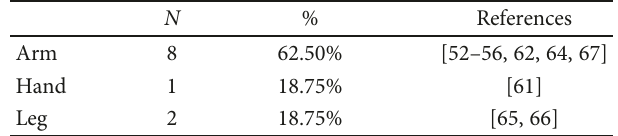
Table 7: Papers using muscle synergies in robotics. N